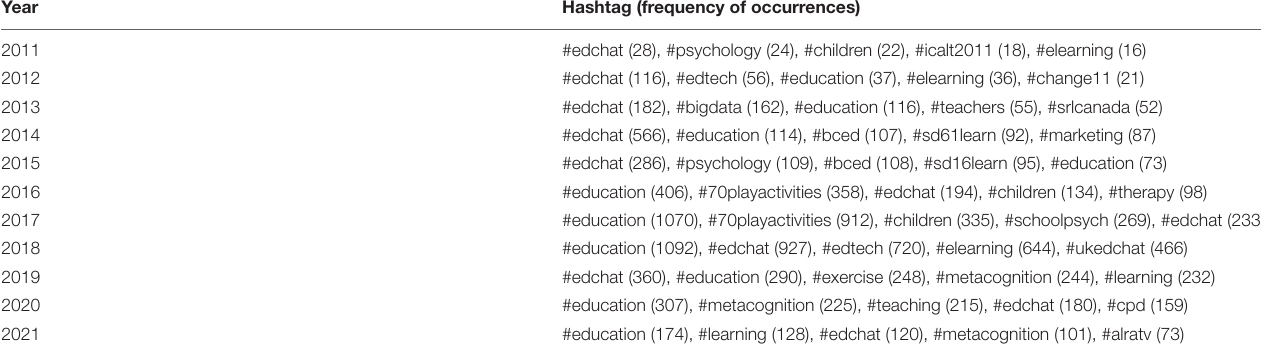
TABLE 3 | Top 5 hashtags per year.